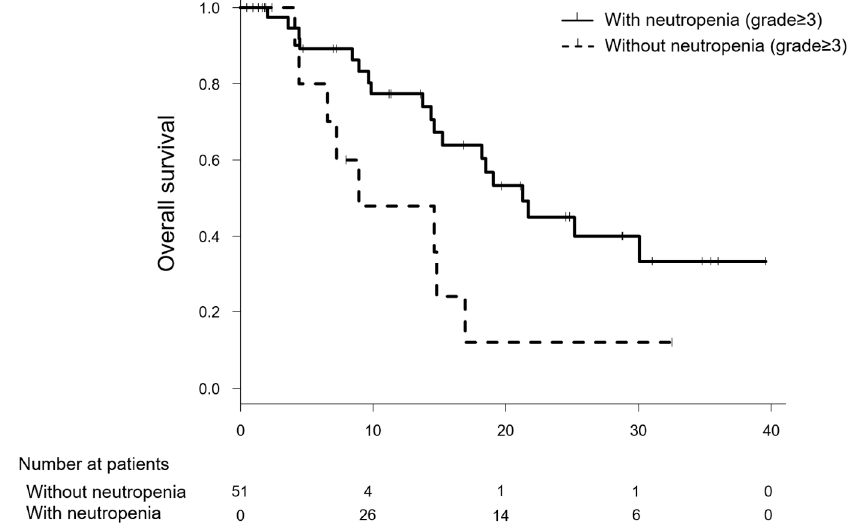
Figure 1. The Simon and Makuch’s modified Kaplan-Meier curves for comparison of overall survival in pancreatic cancer patients who received modified FOLFIRINOX therapy, one curve ( solid line ) represents patients with neutropenia on any study day, and the other curve ( dashed line ) represents those without grade ≥ 3 neutropenia on each day.